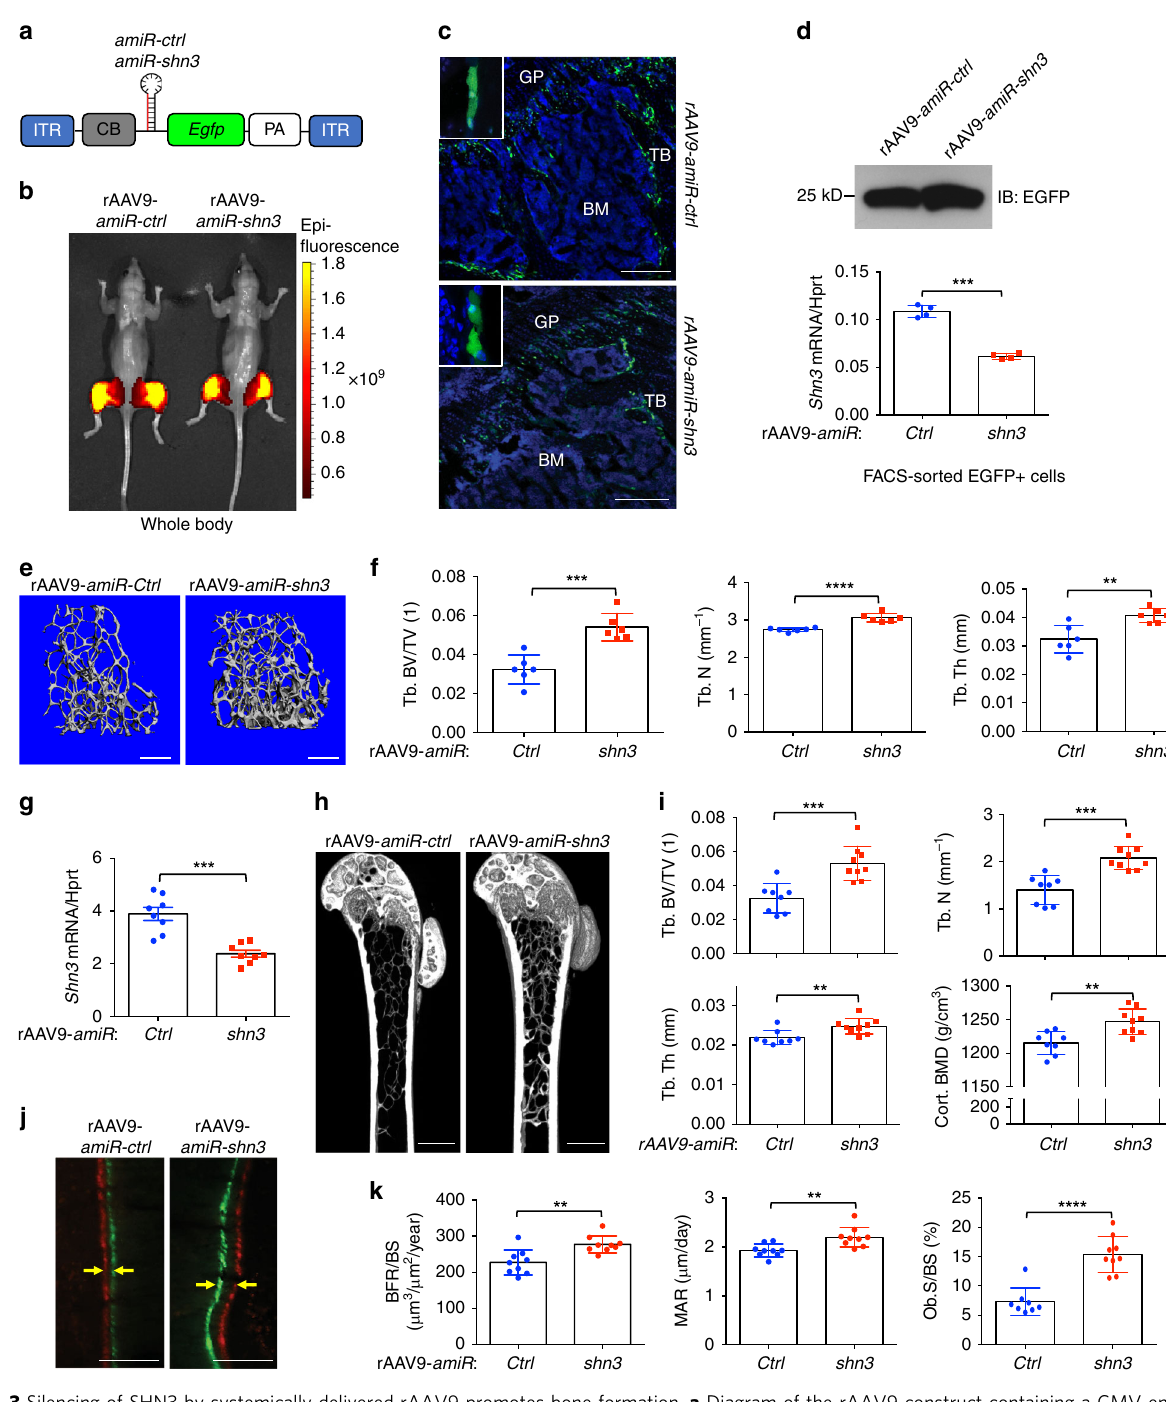
Fig. 3 Silencing of SHN3 by systemically delivered rAAV9 promotes bone formation. a Diagram of the rAAV9 construct containing a CMV enhancer/ chicken β -actin promoter ( CB ), amiR-ctrl or amiR-shn3 , an Egfp reporter gene ( EGFP ), β -globin polyA sequence (PA), and inverted terminal repeat (ITR). b – d Two weeks after i.a. injection of rAAV9 carrying amiR-ctrl or amiR-shn3 into knee joints of 2-month-old male mice, EGFP expression was assessed by IVIS-100 optical imaging ( b ) and fl uorescence microscopy of cryo-sectioned femurs ( c ). Levels of EGFP protein ( d , top) and shn3 mRNAs normalized to hprt ( d , bottom) were assessed in FACS-sorted EGFP-expressing cells from the femur. e , f Two months after i.a. injection of rAAV9 carrying amiR-ctrl or amiR-shn3 into knee joints of 2-month-old female mice, femoral trabecular bone mass was assessed by microCT. Representative 3D reconstruction ( e ) and relative quanti fi cation ( f ) are displayed ( n = 6 per group). g – k A single dose of 4 × 10 11 genome copies of rAAV9 carrying amiR-ctrl or amiR-shn3 were i.v. injected into 3-month-old female mice. After 2 months, shn3 mRNA levels were assessed in the tibial bone RNA and normalized to hprt ( g , n = 8 per group). Femoral trabecular bone mass was assessed by microCT. Representative 3D reconstruction ( h ) and relative quanti fi cation ( i ) are displayed ( n = 8 per group). Representative calcein/alizarin red labeling ( j ) and relative histomorphometric quanti fi cation of BFR/BS, MAR, and Ob.S/BS are displayed ( k ). Arrows indicate the distance between calcein and alizarin red labeling. BFR/BS, bone formation rate/bone surface; MAR, mineral apposition rate; Ob.S/BS, osteoblast surface/bone surface. GP, growth plate; BM, bone marrow; TB, trabecular bone. Scale bars: c 250 μ m; e , h 1 mm; j 50 μ m. Values represent mean ± SD: ** P < 0.01; *** P < 0.001; and **** P < 0.0001 by an unpaired two-tailed Student ’ s t -test ( f , g , i , k